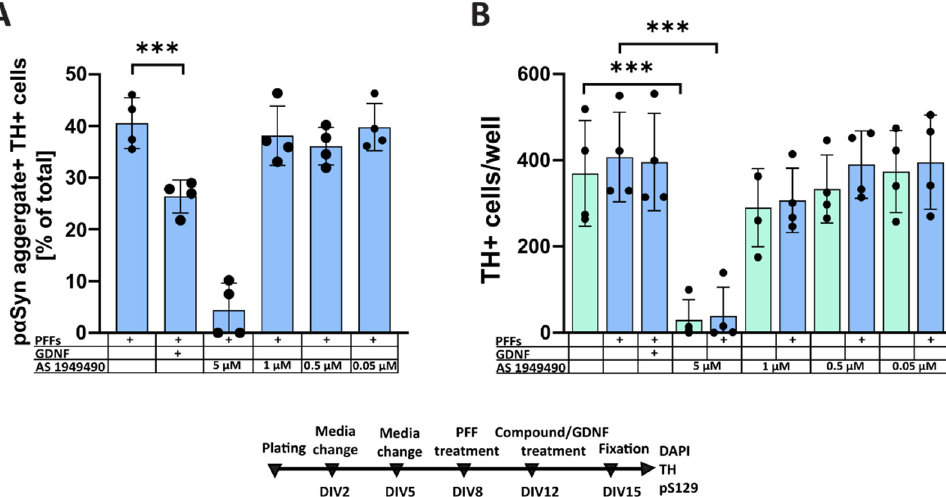
Figure 4. Effect of SHIP2 inhibitor AS1949490 on the accumulation of p α Syn in midbrain dopamin- ergic neurons. Enhancing insulin signaling with SHIP2 inhibitor AS1949490 exerted no significant impact on the accumulation of p α Syn in midbrain dopaminergic neurons in concentrations that have not affected neuron survival. ( A ) Quantification of p α Syn-positive accumulations within TH- positive dopaminergic neurons. GDNF added to the cells on DIV12, the same day as a compound, significantly reduced the aggregation of intracellular p α Syn, while AS1949490 showed no similar effect at any studied concentration. Note: AS1949490 in a concentration of 5 µ M shows a significant decrease in TH-positive cell vitality, making interpretation of its effects on α -syn accumulation at this concentration unfeasible. ( B ) The number of TH-positive cells per well AS1949490 in a concentration of 5 µ M proved to be toxic to the dopaminergic neurons of primary embryonic midbrain cell culture (two-way repeated-measures ANOVA, followed by Tukey’s multiple comparison test, *** p < 0.001, n = 4 independent experiments, data are mean ±